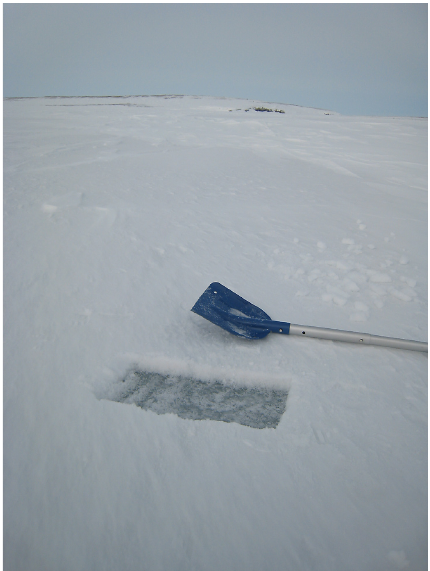
Fig. 8. Thin snow on sea ice in the Canadian Arctic, Site 4, near Cape Parry (70 ◦ N, 125 ◦